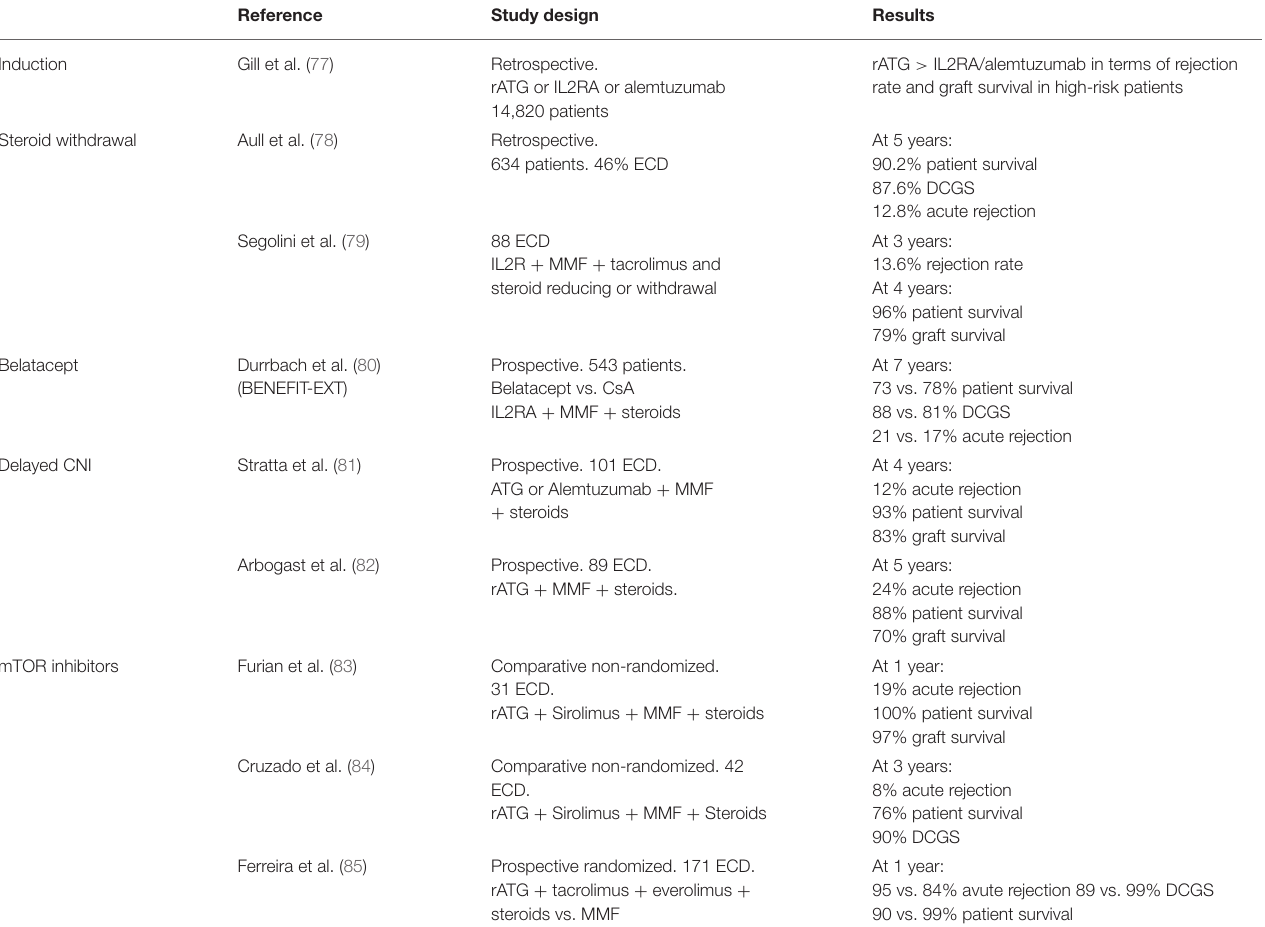
TABLE 1 | Study characteristics of trials evaluating immunosuppressive regimen in expanded criteria